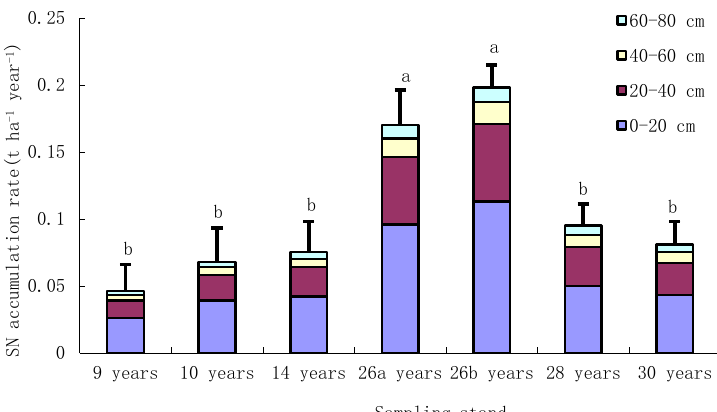
Figure 2. Soil nitrogen (SN) accumulation rate of plantations at different depths in soil profile. Note: 26a, mixed plantation with L. leucocephala , E. camaldulensis and C. cajan , aged 26; 26b, mixed plantation with L. leucocephala and C. cajan , aged 26. Data are means ± stand deviation, with the same letters among stands denote insignificant differences ( p = 0.05).